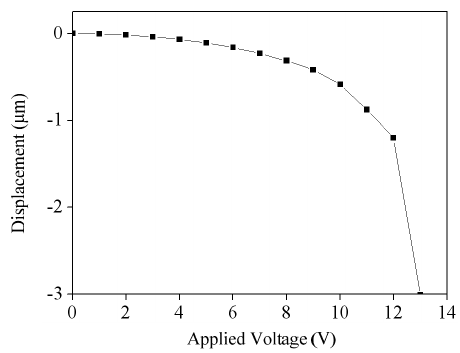
Figure 3. Relation between membrane displacement and actuation voltage for the switch.